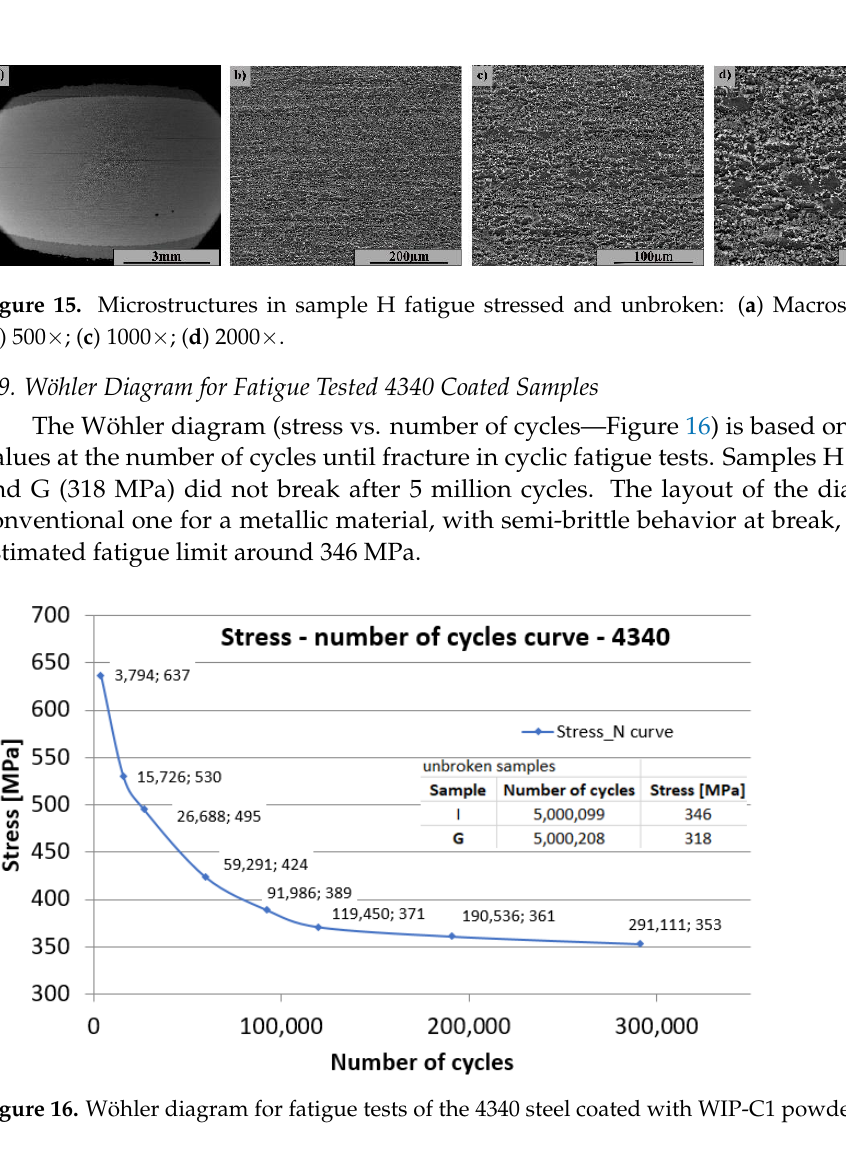
Figure 14. Microstructures from sample K in the breakage area: ( a ) Macroscopic view; ( b ) 500×; ( c ) Figure 15. Microstructures in sample H fatigue stressed and unbroken: ( a ) Macroscopic view; ( b )